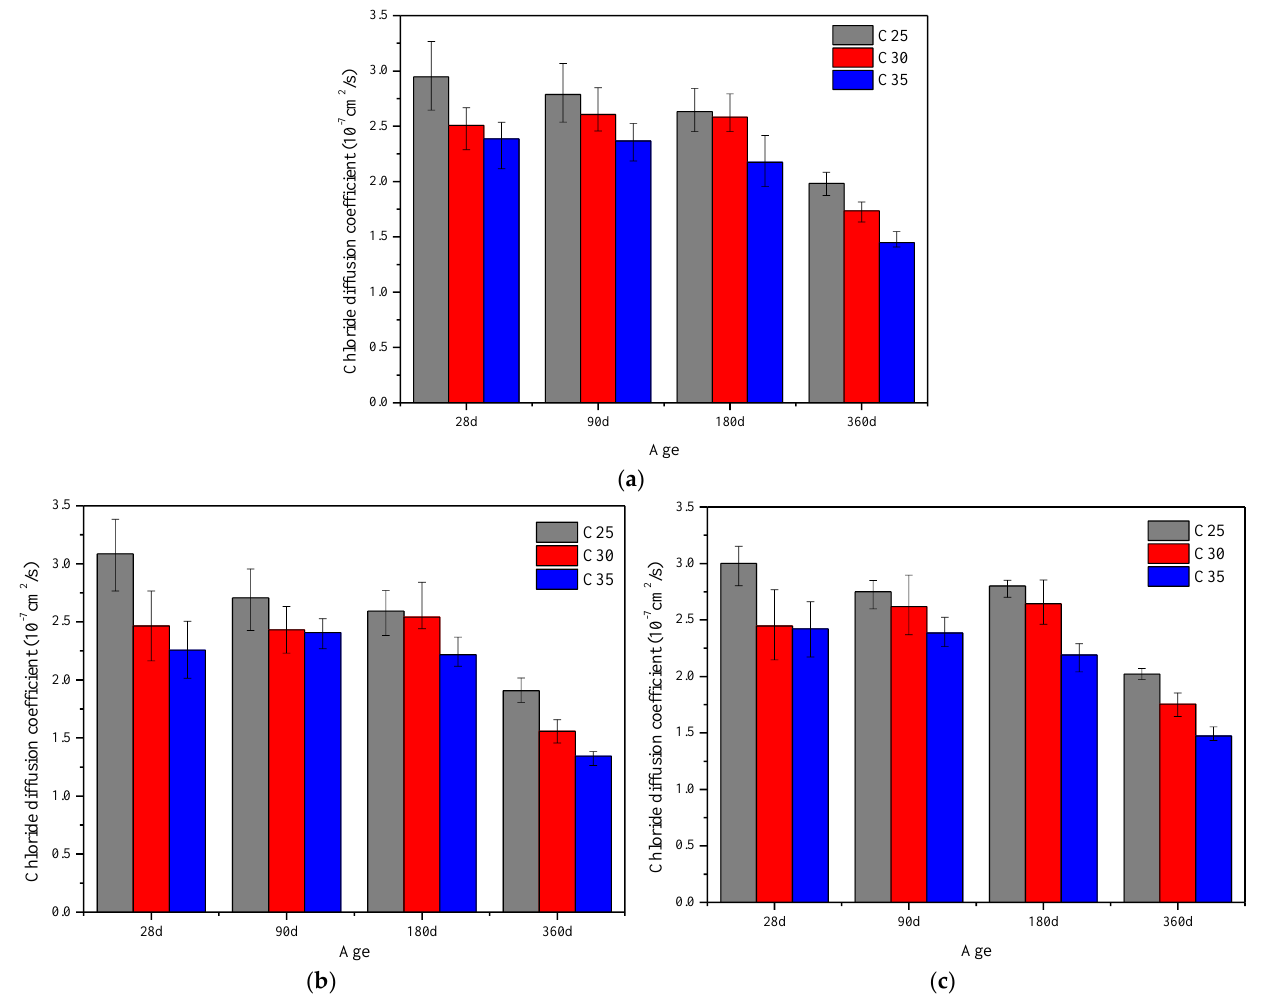
Figure 6. Diffusion coefficients of chloride ions in C25, C30 and C35 concrete in different aggressive environments: ( a ) sulfate, ( b ) chloride salt and ( c ) compound salt.